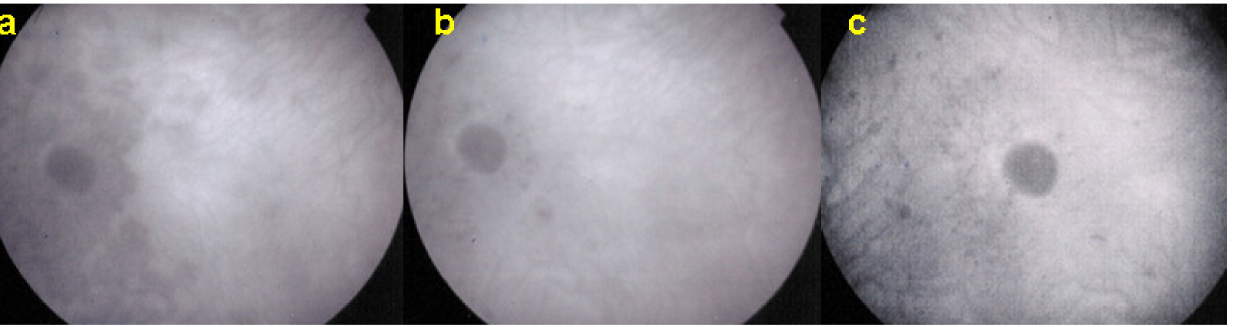
Figure 20. ICGA pictures of MFC at presentation ( a ), after 1 month ( b ) and 4 months ( c ). Peripapillary confluent hypofluo- rescence and scattered hypofluorescent areas along superior temporal arcade at presentation ( a ), which almost completely resolved after one month ( b ). However, at 4 months, ( c ) hypofluorescent areas are still